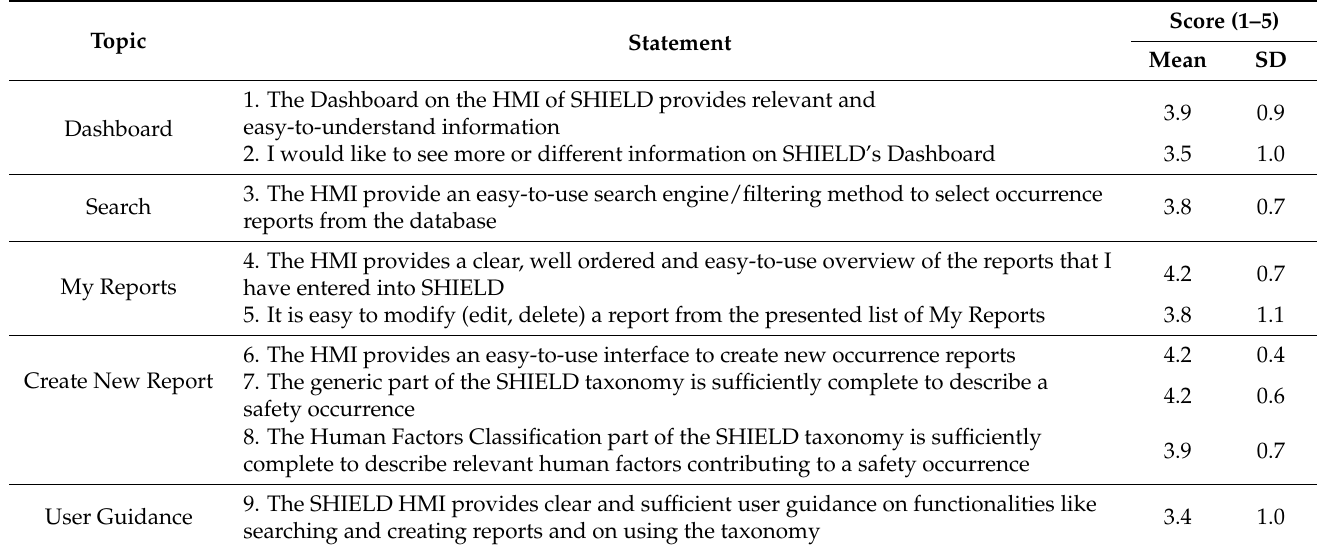
Table 3. Evaluation scores of aviation and maritime